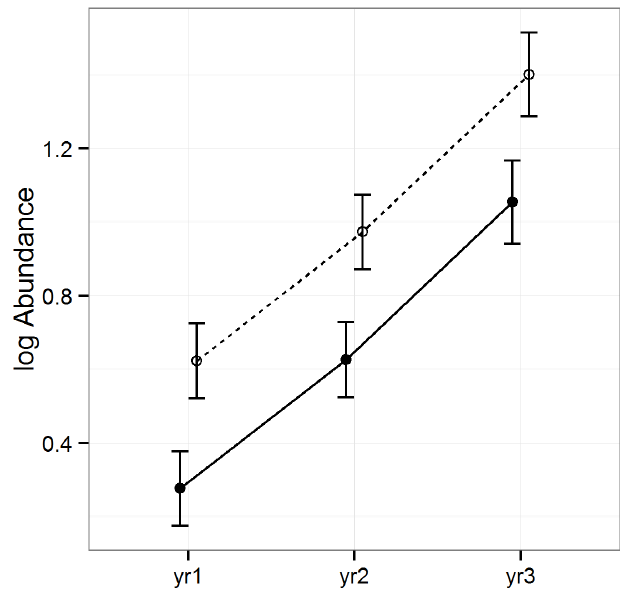
Figure 5. Predicted means and standard errors of Hemiptera abundance during three years of seasonal pitfall trapping in pine plantations in North Florida against fixed effects from the most parsimonious model based on log-likelihood ratio tests; raked stands are displayed with open circles and dashed lines, intact stands with solid circles and lines; 2008 as yr1, 2009 as yr2 and 2010 as